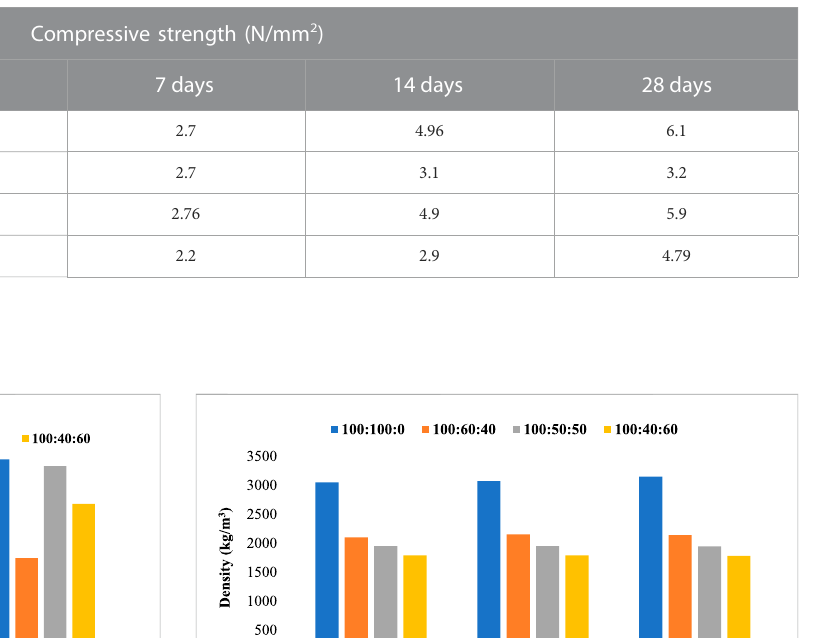
TABLE 3 Compressive strength results.